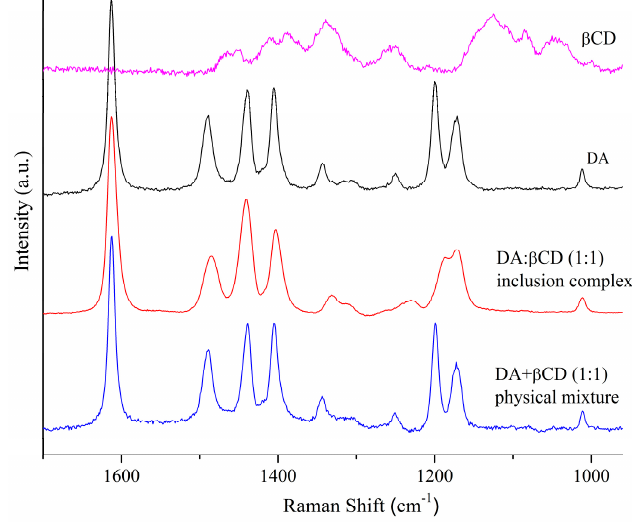
Figure 2. Raman spectra of DA, β CD, and the DA: β CD (1:1) inclusion complex and DA + β CD physical mixture of 1:1 molar ratio in the 1700–950 cm − 1 wavenumber range.